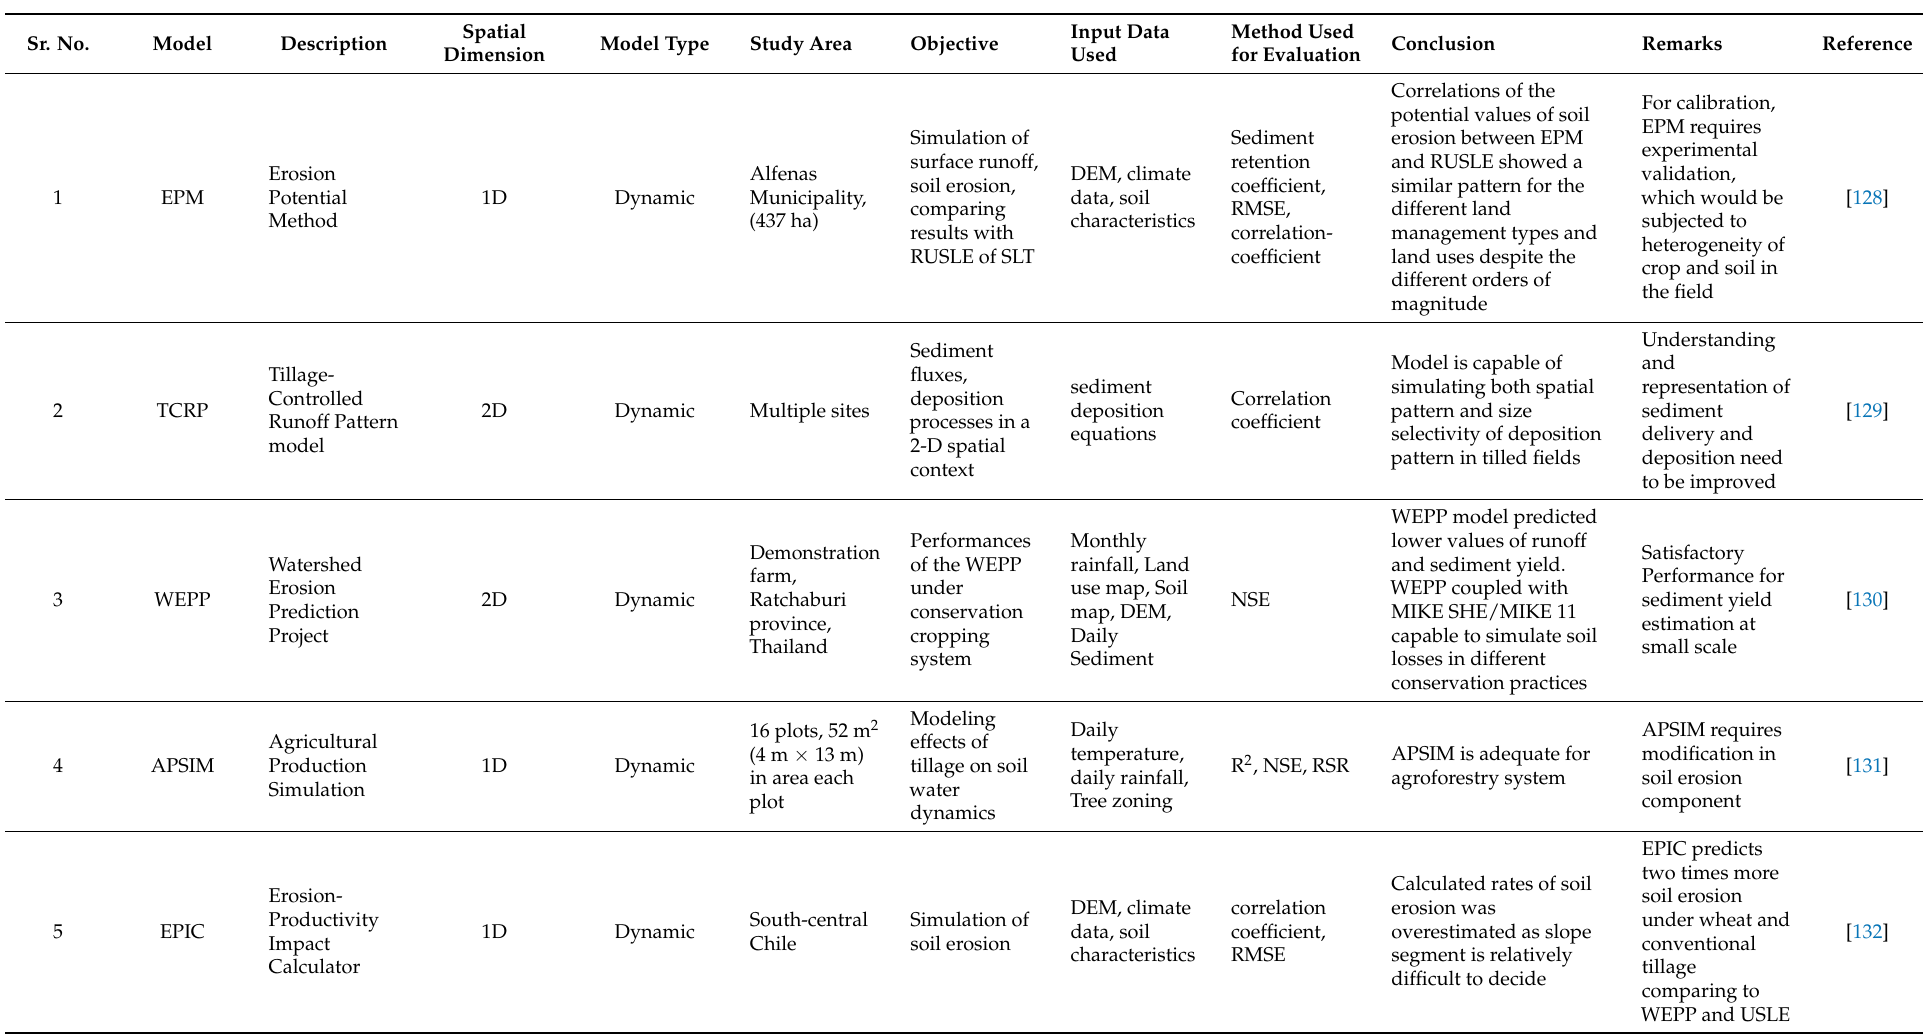
Table 6. Examples of applications of some selected field scale soil erosion